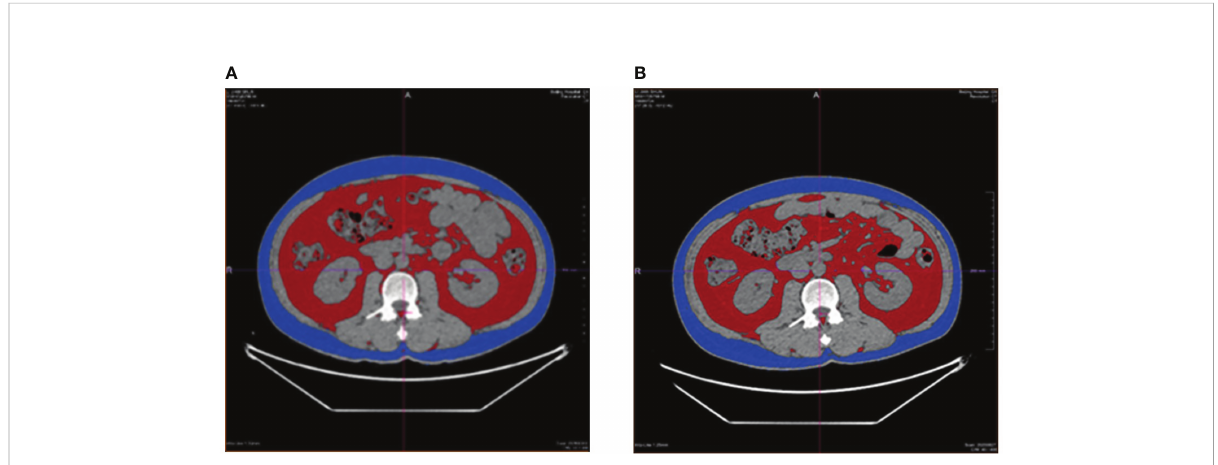
FIGURE 2 Before-and-after comparison of visceral fat area, the red area, and the subcutaneous fat area of abdomen, the blue area, in a patient receiving liraglutide intervention. (A) , before the intervention of liraglutide; (B) , after the intervention of